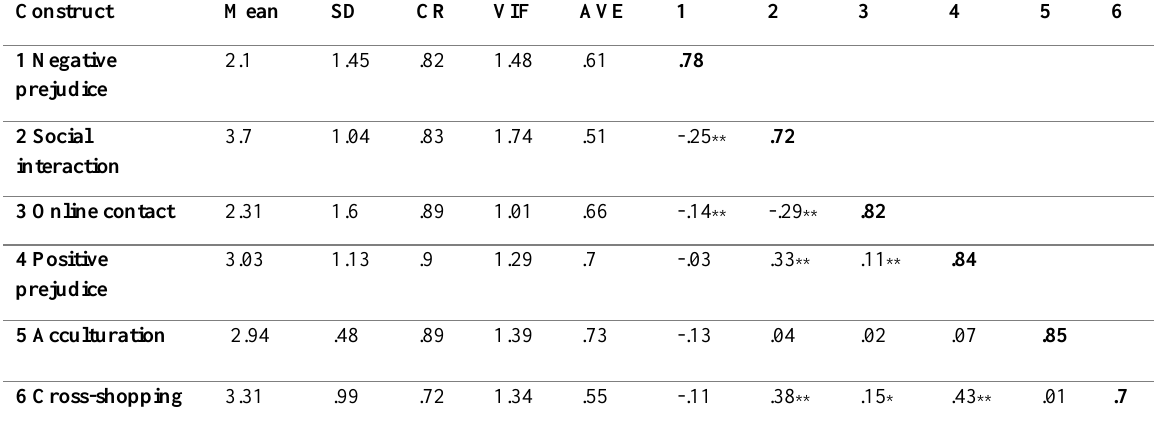
Table 2: Composite reliability, VIF, AVE, and correlation of constructs’